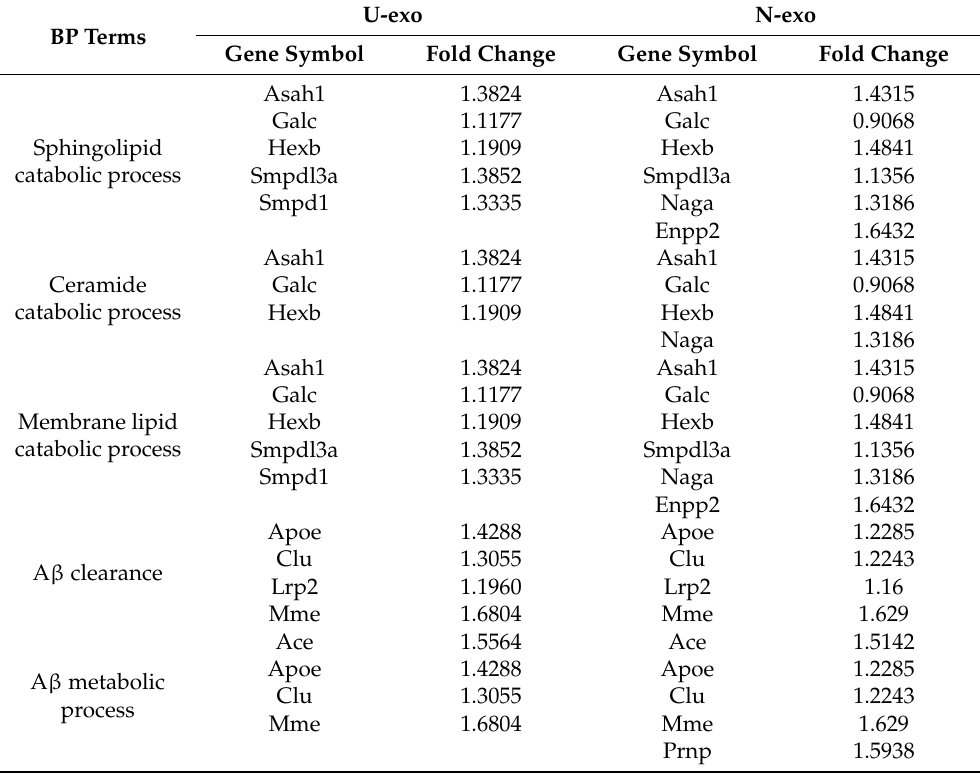
Table 4. Summary of proteins enriched in five BP terms with high enrichment in both U-exo and